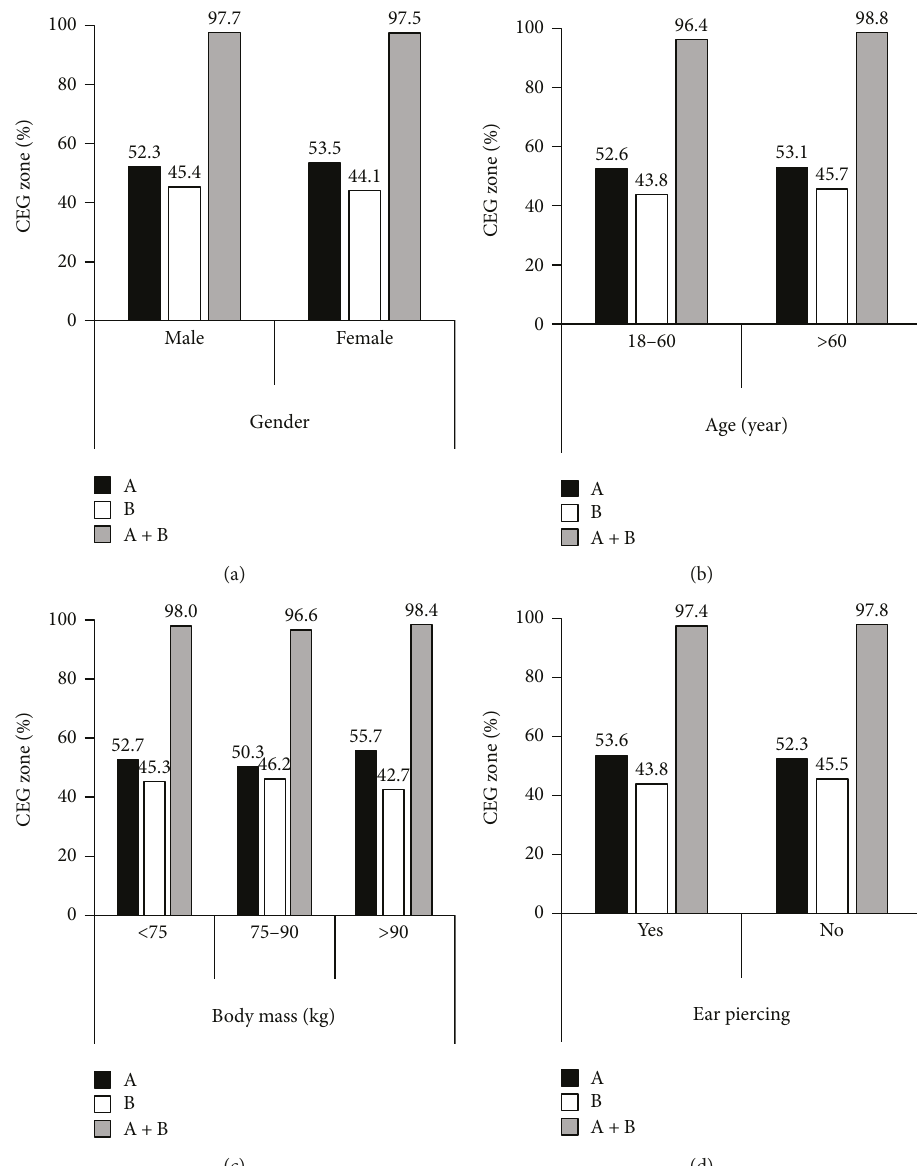
Figure 3: Clinical accuracy as a function of (a) gender, (b) age, (c) body mass, and (d) ear